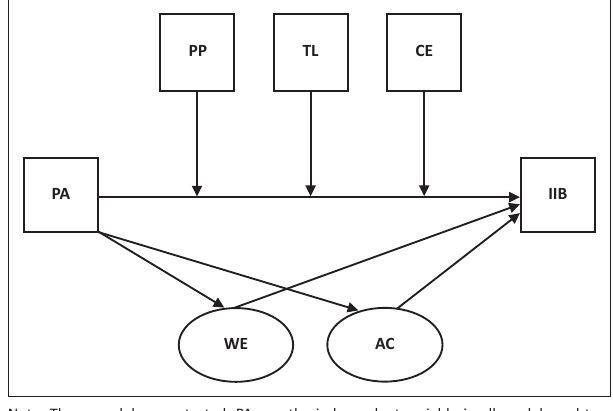
FIGURE 1: Performance appraisal-innovation model with mediator and moderator